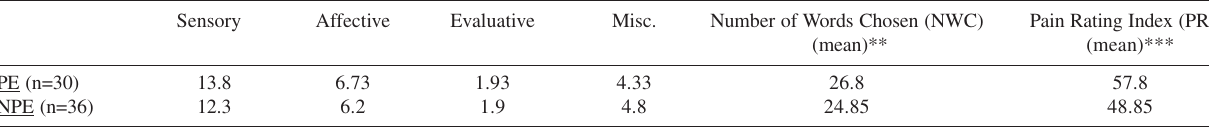
Table 4 - McGill Pain Questionnaire: Precipitating (PE) and No Precipitating Events (NPE)